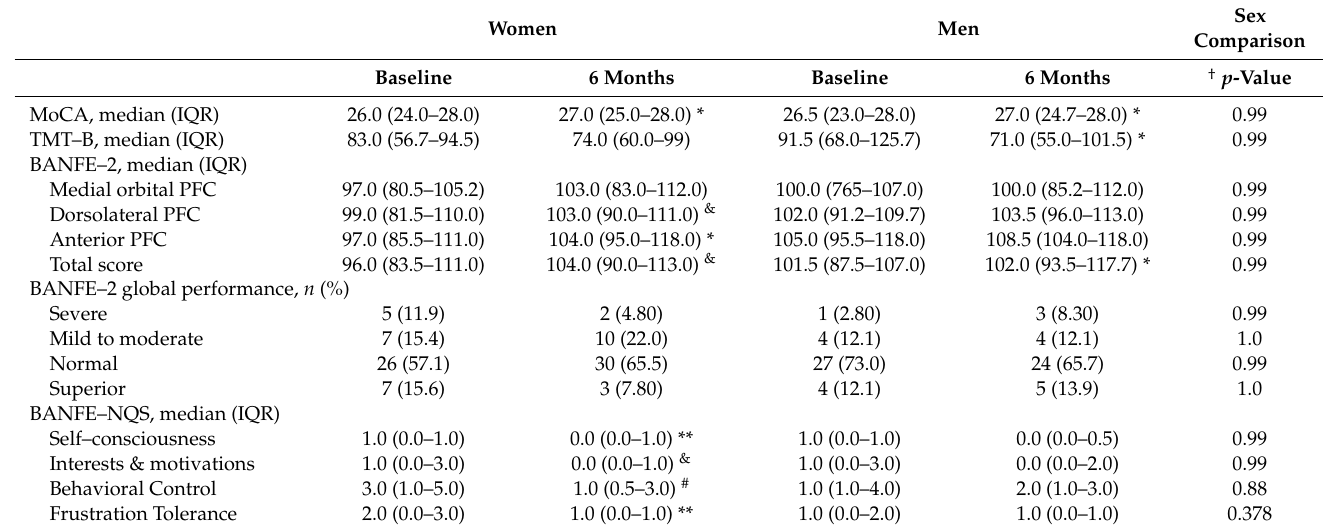
Table 4. Comparison of cognitive performance after six months of a multidisciplinary weight loss program by